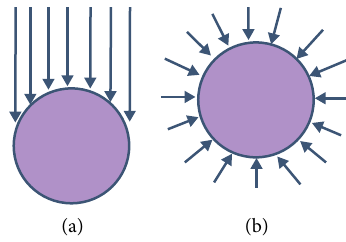
Figure 2: Collimated (a) vs. diffuse light (b) on a spherical